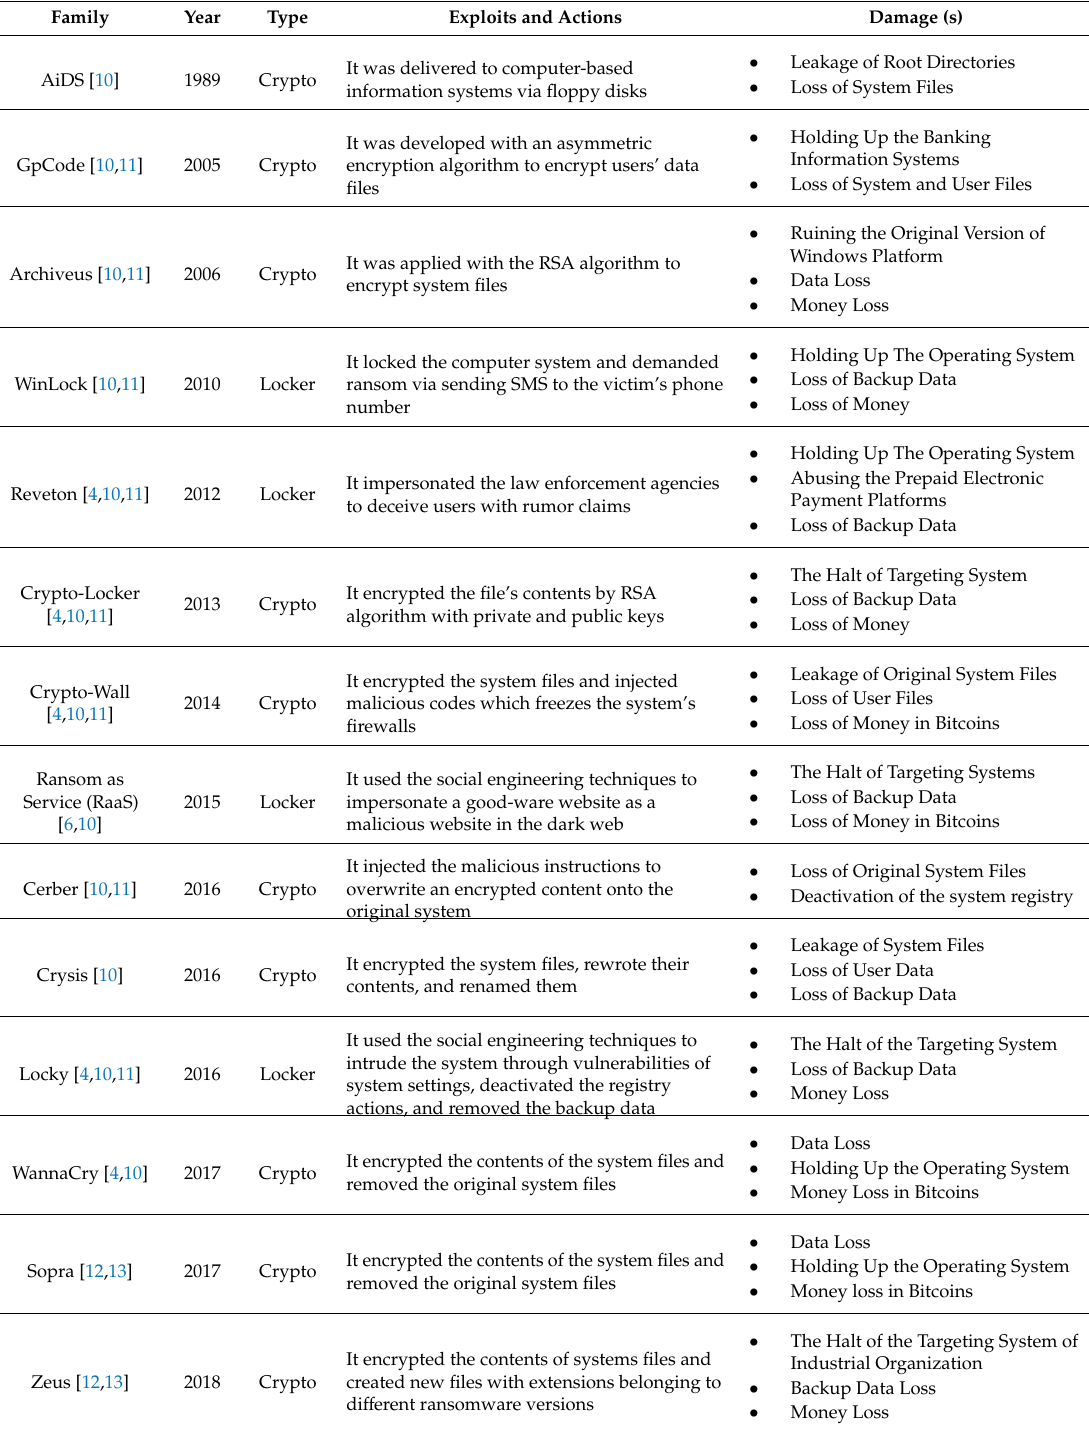
Table 1. Time-line summary of ransomware